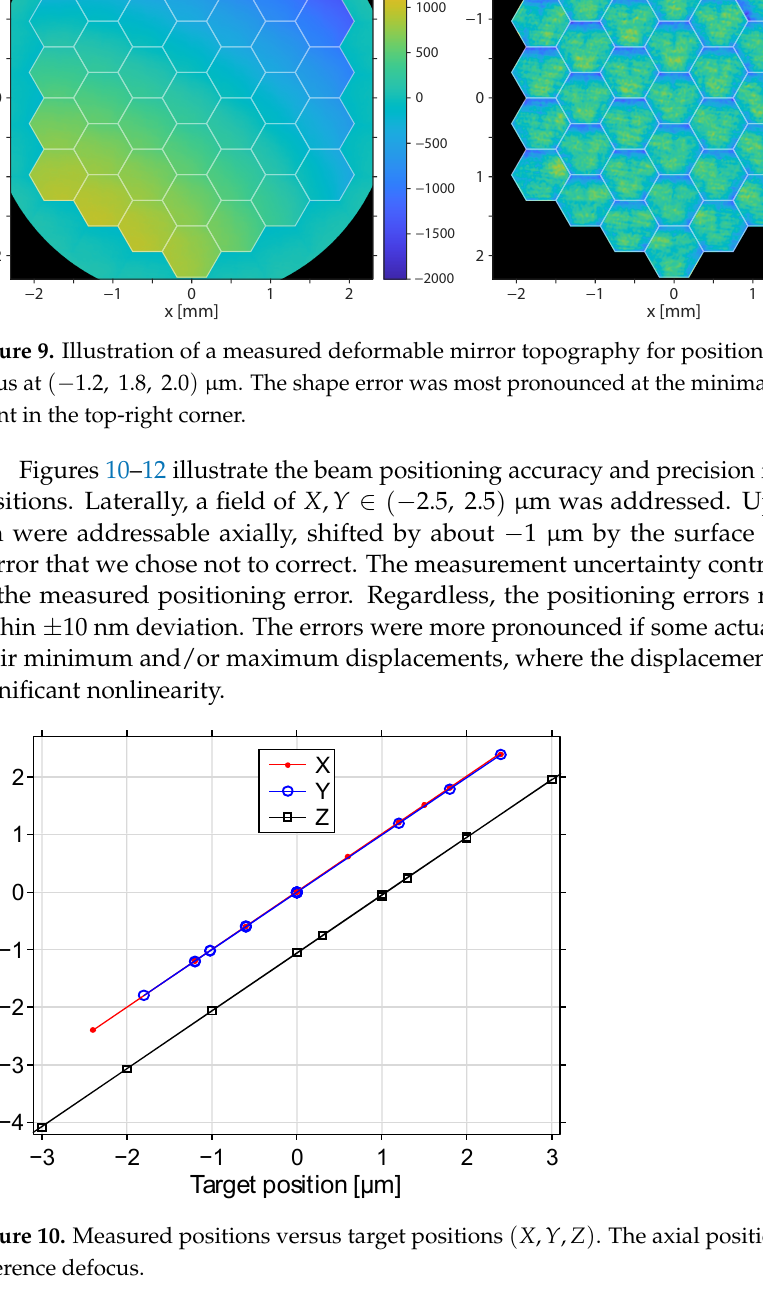
Figure 9 and Supplementary Video S1 illustrate the measured deformable mirror topographies and the shape errors for steering the laser beam focus at different target positions ( X , Y , Z ) . The shape errors were most pronounced on the segments whose actuator(s) were driven close to the minimum or maximum voltage. There, the open-loop calibration could not fully compensate the nonlinear actuator responses. The crosstalk between the actuators of one segment may be a major cause for the observed deviations.